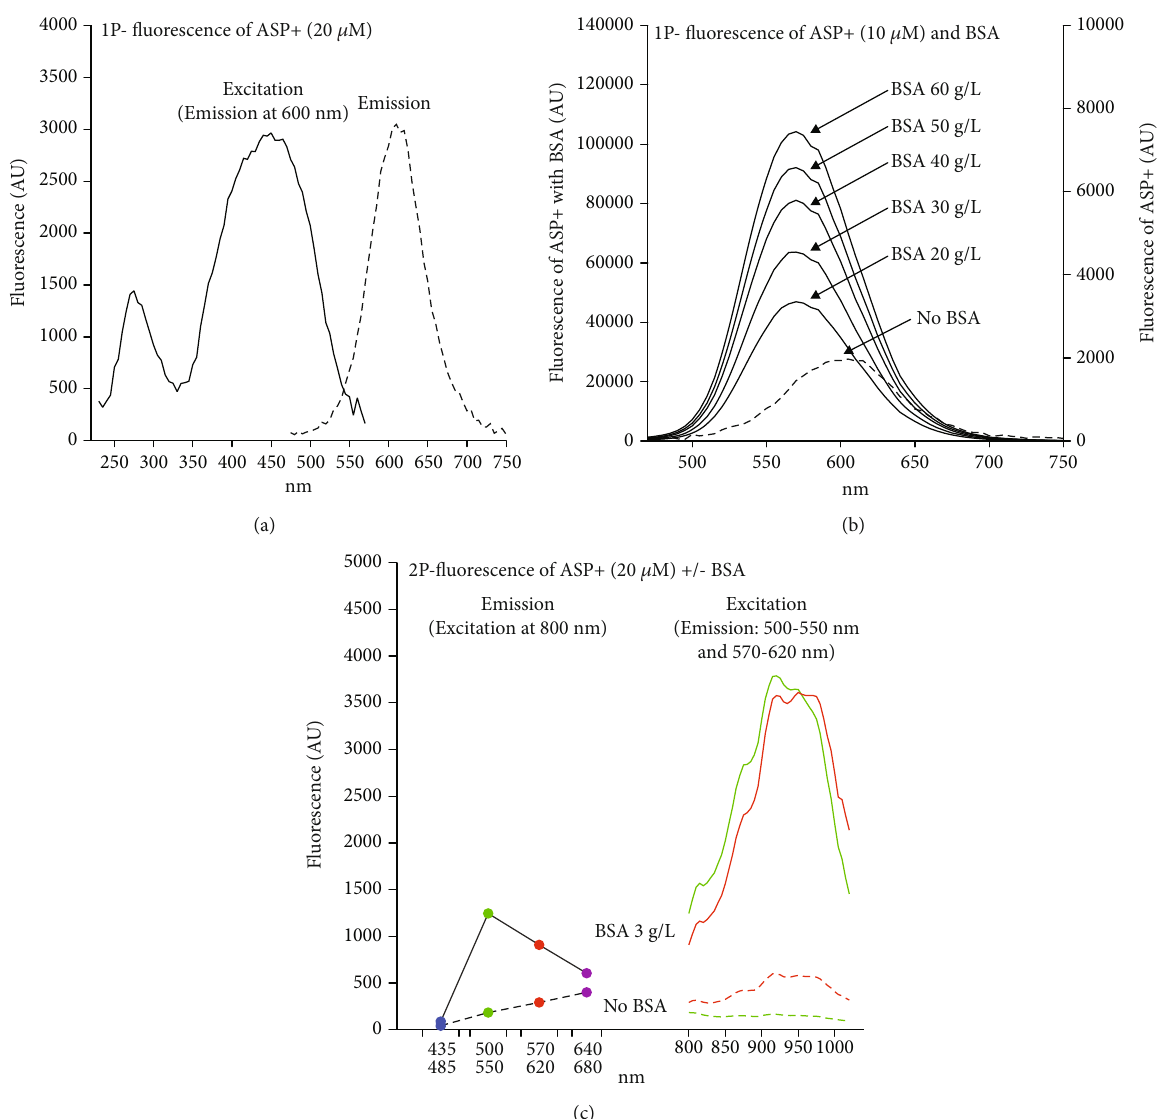
Figure 4: Fluorescence spectra of ASP+. (a) 1-photon fl uorescence excitation spectrum and emission spectrum of ASP+. Maximum excitation was found at 450 nm (emission recorded at 600nm), and maximum emission was seen at 605nm. (b) The e ff ect of BSA on the 1-photon fl uorescence emission spectrum of ASP+. BSA induces a marked concentration-dependent increase in fl uorescence (left y -axis) compared to ASP+ alone (right y -axis). In addition, BSA induces a blue shift of the emission peak from 605 to 570 nm. (c) Left: fl uorescence emission from ASP+ in the absence (broken line) and presence of BSA (full line) in four wavelength intervals following excitation at 800 nm using a pulsed Ti:sapphire laser. Right: two-photon fl uorescence excitation spectrum of ASP+ in the absence (broken line) and presence of BSA (full line). Maximum 2P excitation was obtained in the red channel (570 – 620nm) at 920nm and the emission from ASP+ alone was generally very low. BSA enhanced and induced a blueshift in the emitted